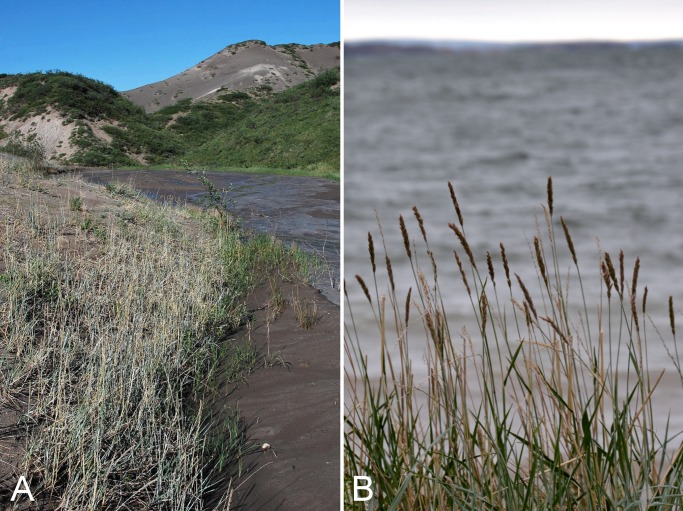
Leymus mollis subsp. villosissimus.(A) Habitat, Saarela et al. 4174. (B) Habit, Kugluktuk, Nunavut, 27 July 2014. Photographs J. M. Saarela (A) and P. C. Sokoloff (B).